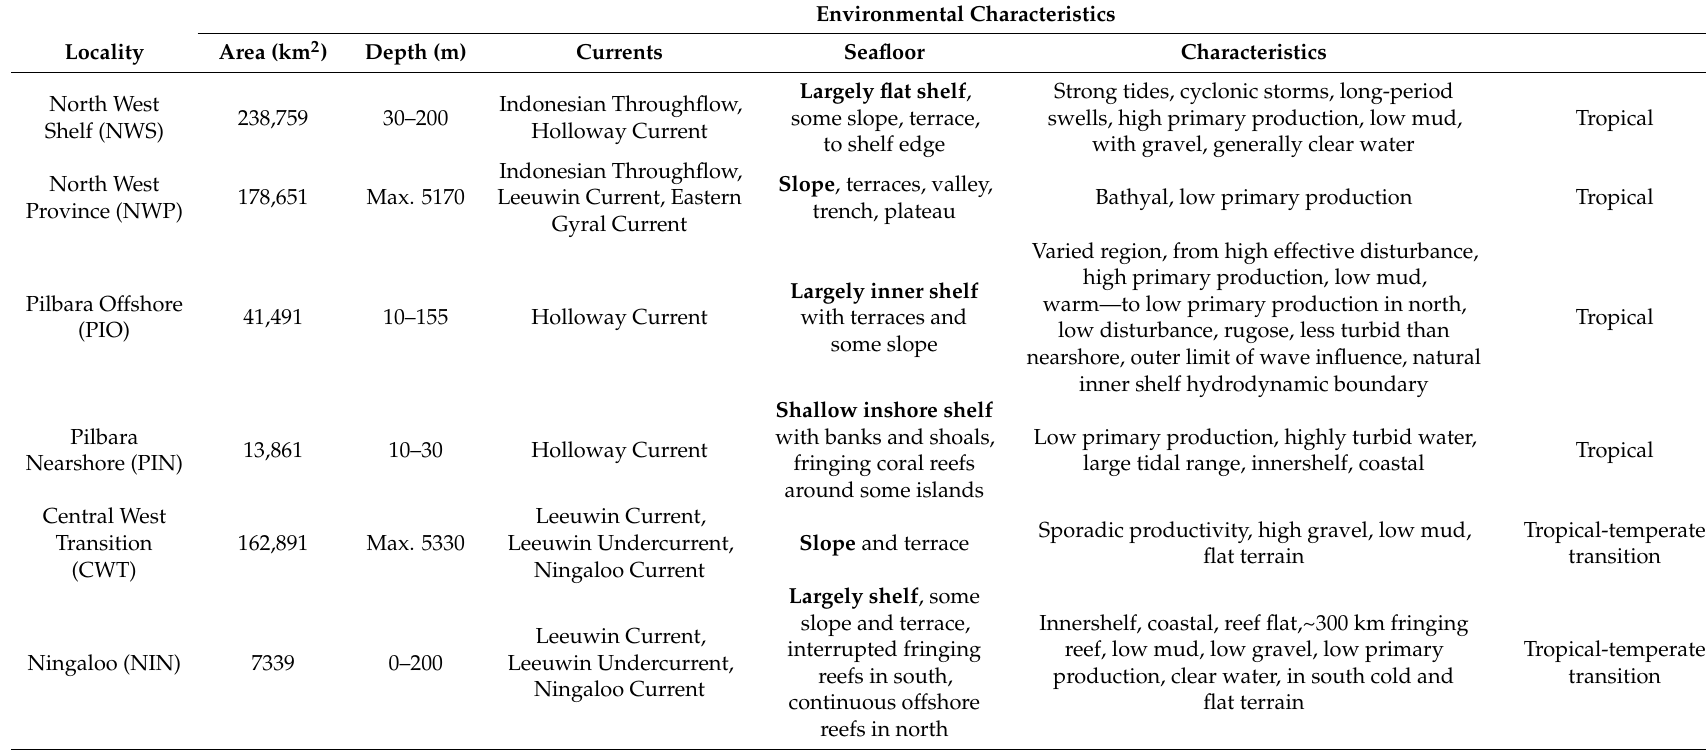
Table 1. Characteristics of the six bioregions examined in this study. Eighty Mile Beach and North West Transition bioregion characteristics are not provided as no sponges were recorded from these regions